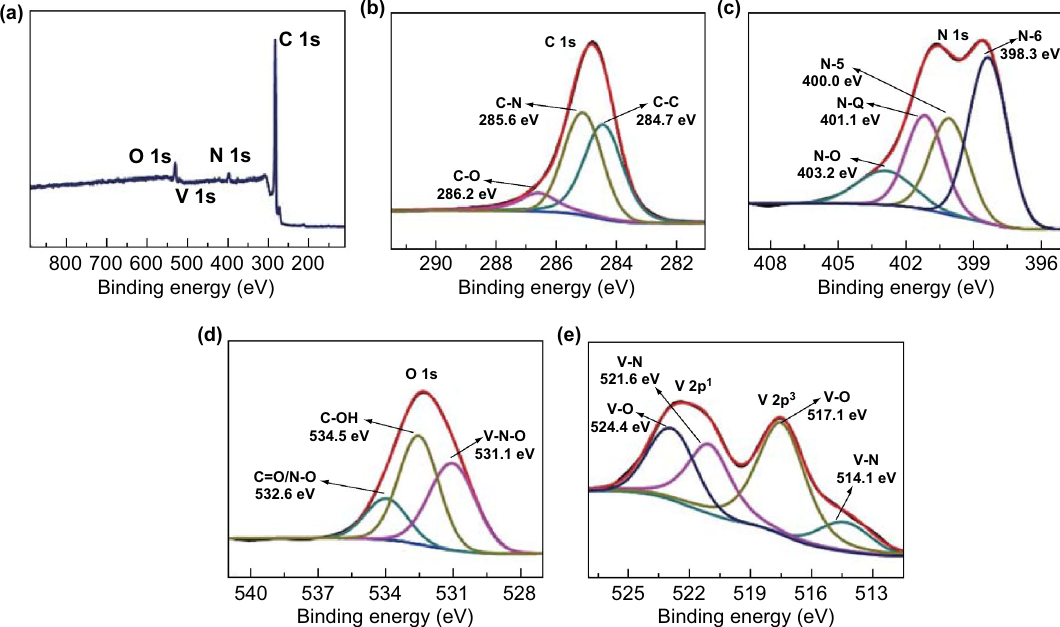
Fig. 3 X-ray photoelectron spectra of the VN/C